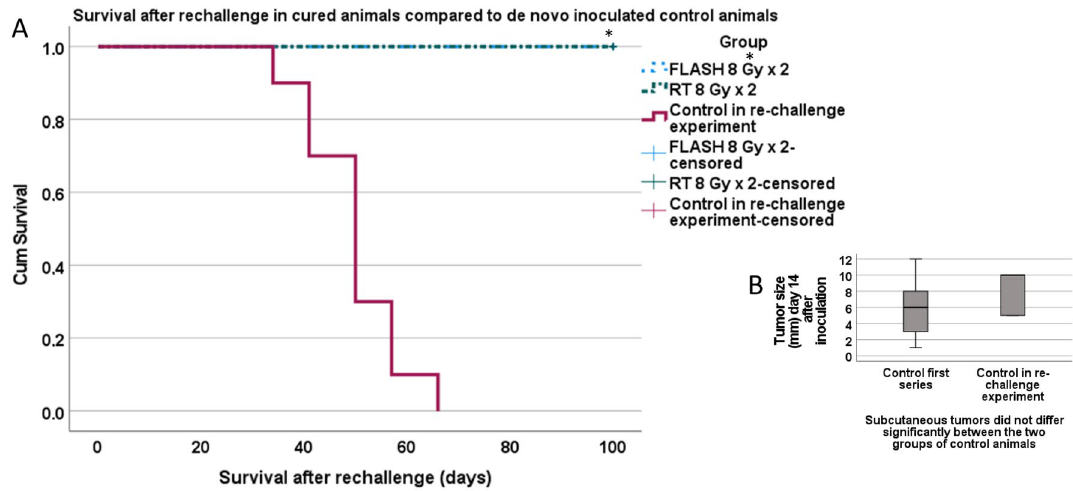
Figure 4. Re-challenge of animals with long-term tumor control. ( A ) All animals that managed to reject the subcutaneous tumors were subject to tumor re-challenge. They were monitored until day 191 after the first tumor cell inoculation. ( B ) Tumor size did not differ significantly between the two groups of control animals, from the first series versus the de novo inoculated controls in the re-challenge series.